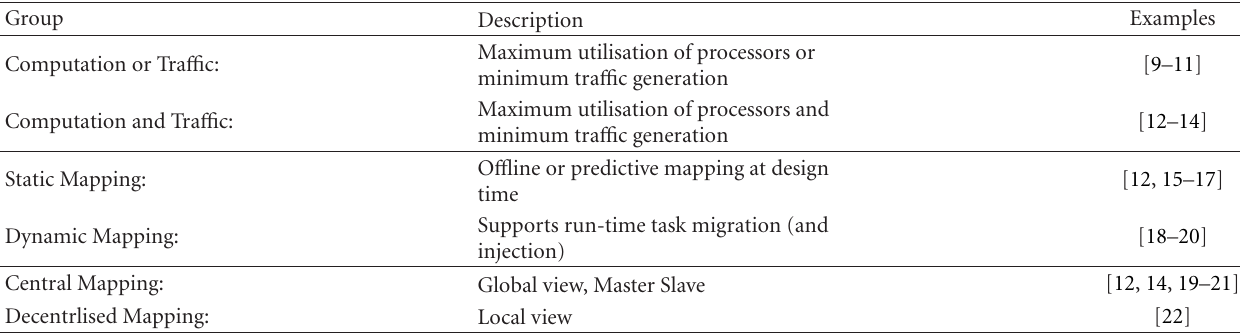
Table 1: Classification of related work on task